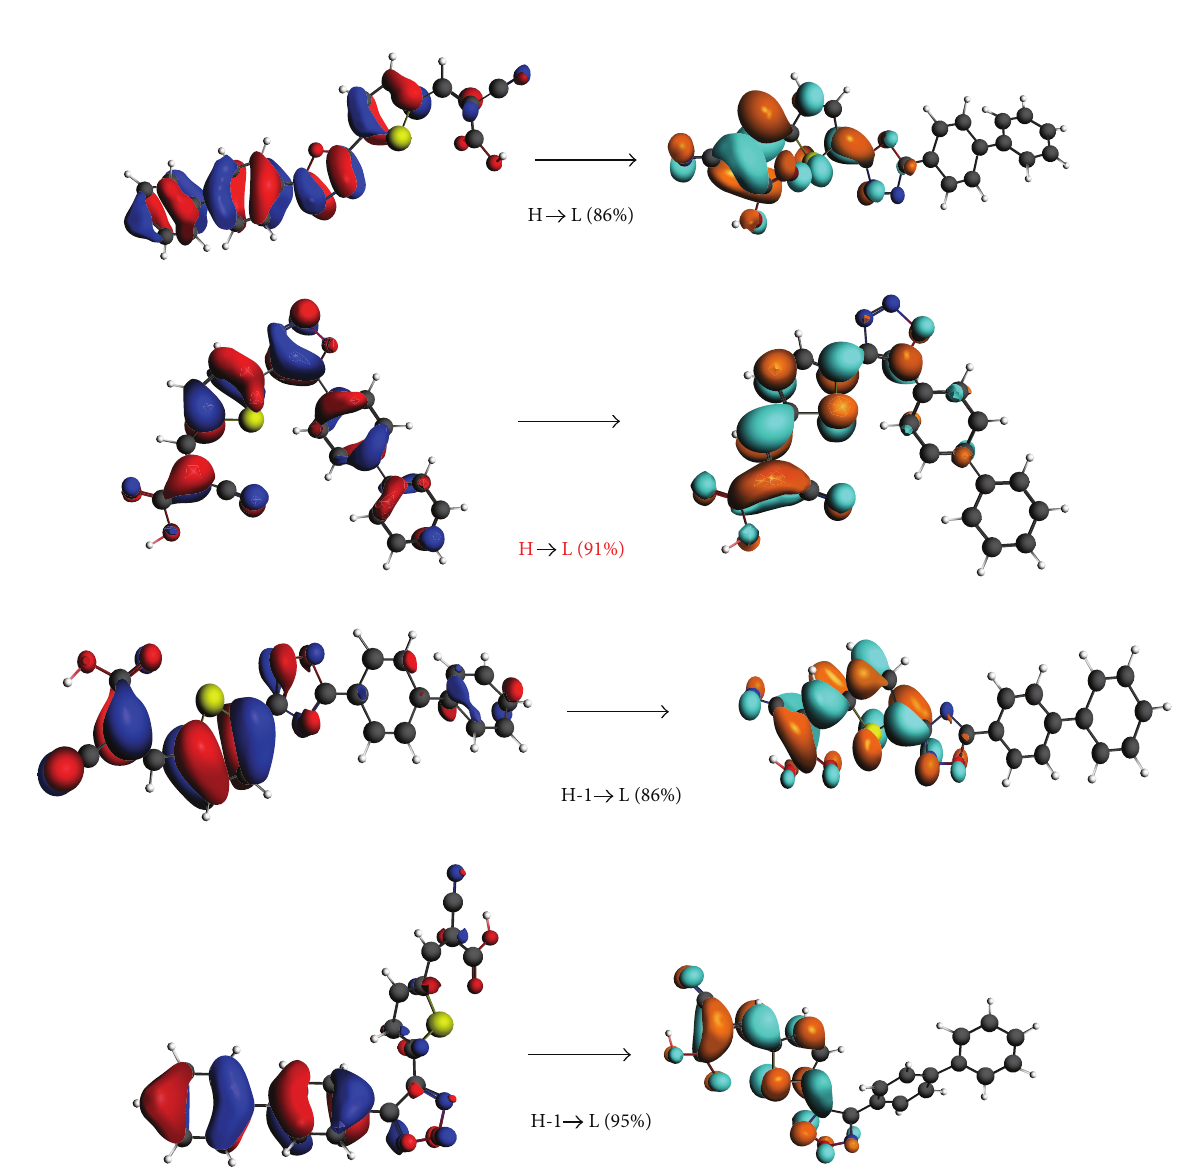
Figure 3: Major transition of systems